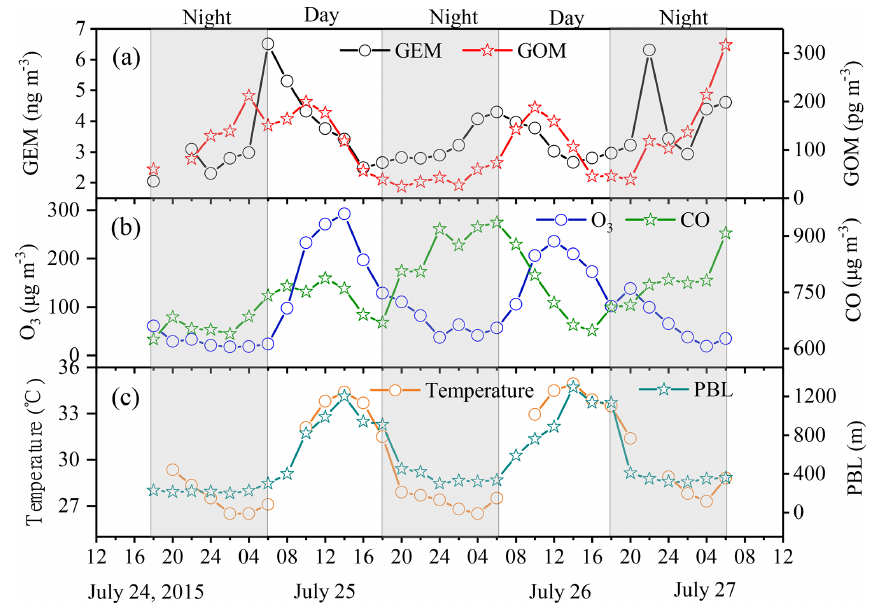
Figure 11. A case study of GEM oxidation from 24 to 27 July 2015. The time series of GEM, GOM, O 3 , CO, temperature, and PBL are plotted. The shaded parts represent nighttime.